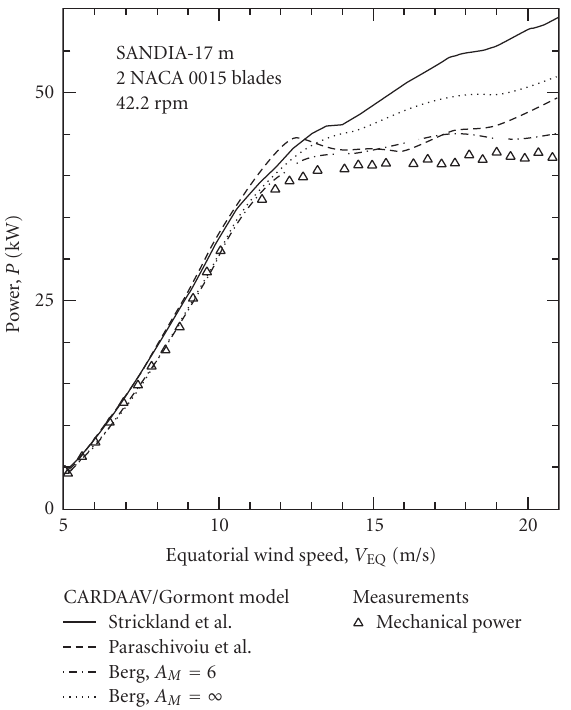
Figure 2: Comparison of CARDAAV results with experimental and other numerical predictions. (adapted from Paraschivoiu 2002)